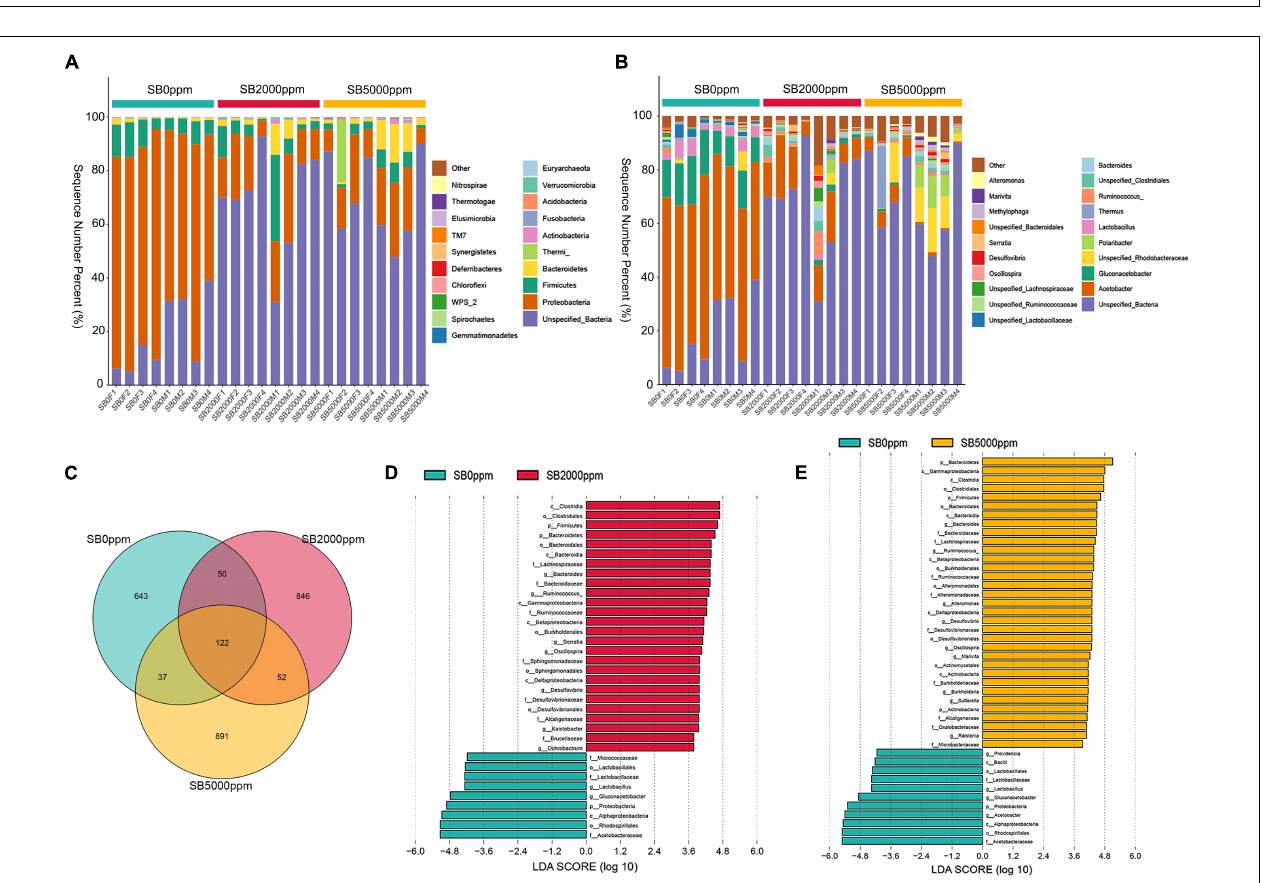
FIGURE 3 | Commensal microbial composition and species enrichment analysis of Wolbachia -excluded data. (A) Commensal microbial composition at the phylum level. (B) Commensal microbial composition at the genus level. (C) Common and unique OTUs number analysis. (D) Linear discriminant analysis (LDA) scores of commensal microbial species in flies fed with 2,000 ppm of SB. (E) LDA scores of commensal microbial species in flies fed with 5,000 ppm of